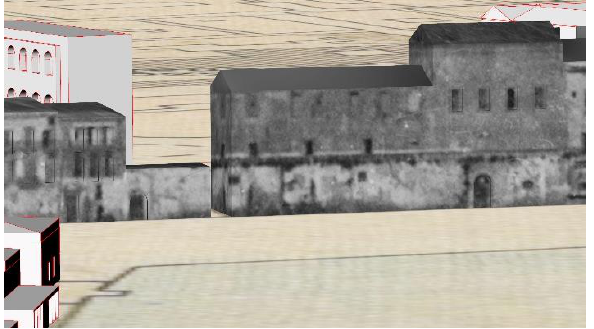
Figure 9: The textured reconstruction